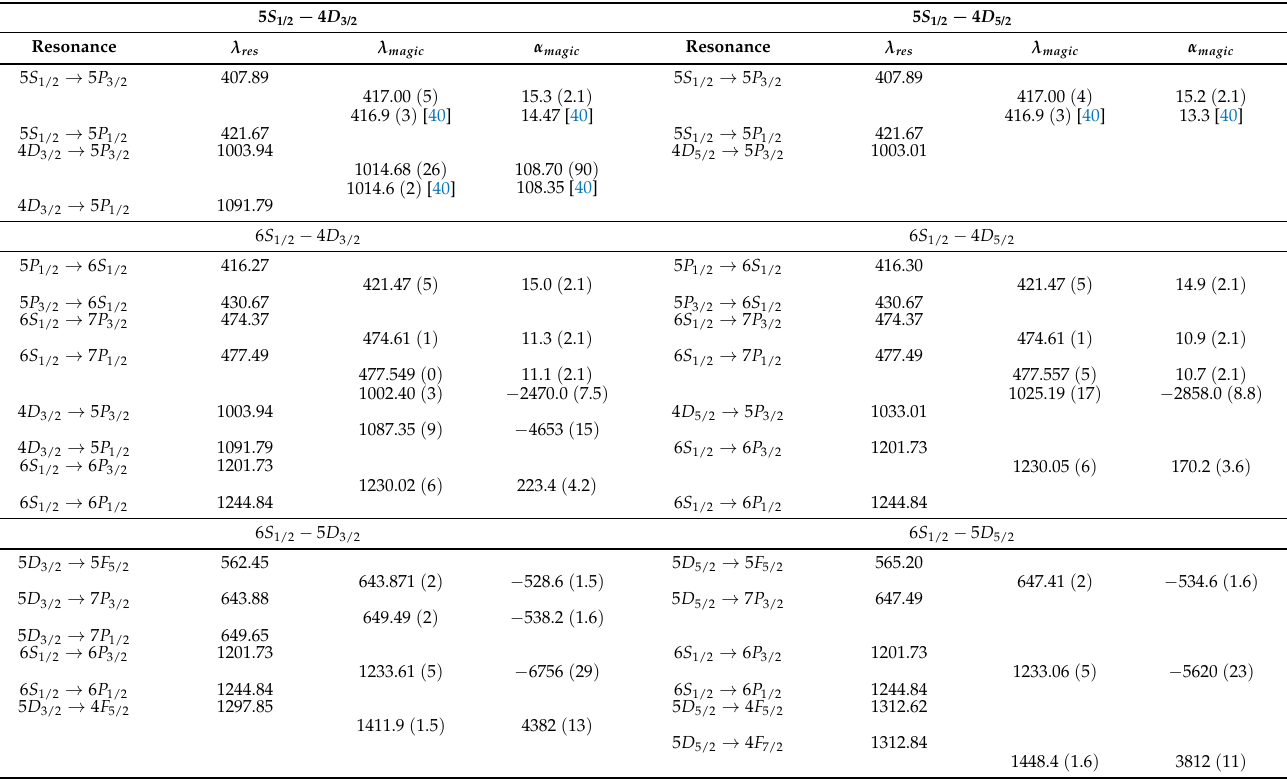
Table 3. Magic wavelengths λ magic (in nm) with their corresponding polarizability α n ( ω ) (in a.u.) along with their comparison with the available literature for ( 5,6 ) S 1/2 − 4 D 3/2,5/2 and 6 S 1/2 − 5 D 3/2,5/2 transitions in Sr +